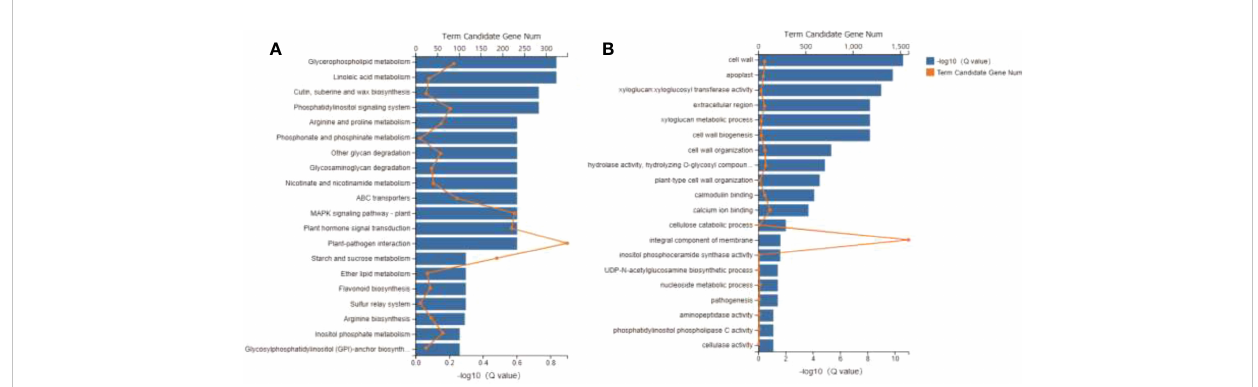
FIGURE 2 Global transcriptome of Rhododendron chrysanthum Pall. in response to cold stress. (A) KEGG classi fi cation of all DEGs annotated. (B) DEG enrichment through